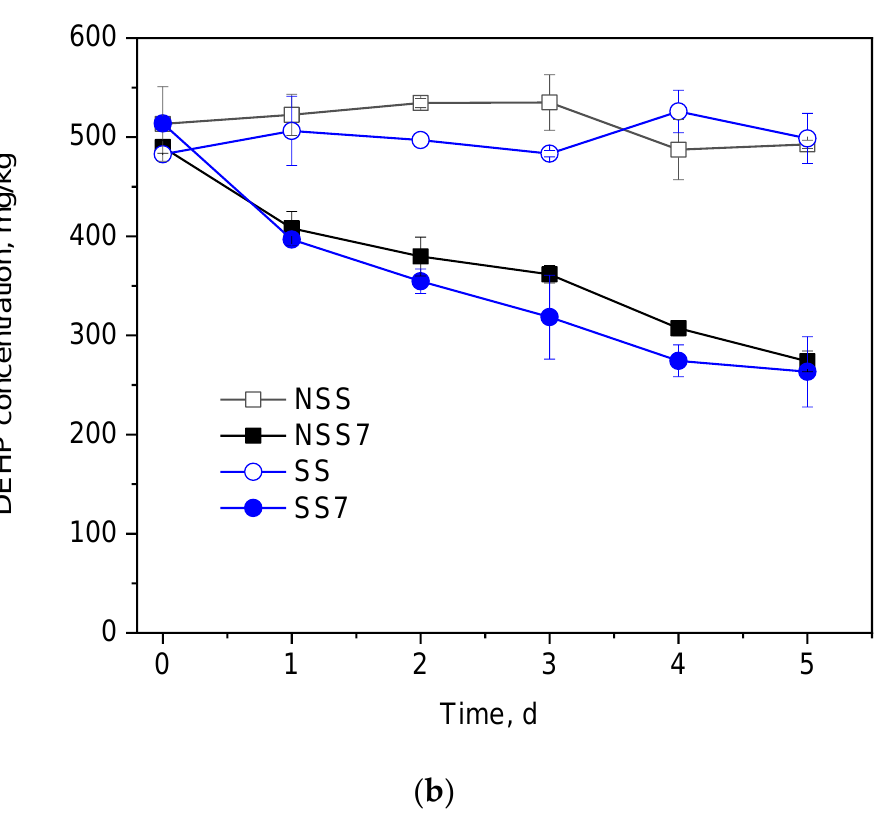
Figure 3. ( a ) PAEs Degradation and growth ability of GZ-YC7 in the BSM containing 800 mg/L mixed four PAEs (200 mg/L of DEP, DBP, DEHP, and DnOP); ( b ) DEHP degradation by GZ-YC7 in soil. NSS: Non-sterilized soil without GZ-YC7; NSS7: Non-sterilized soil with GZ-YC7; SS: Sterilized soil without GZ-YC7; SS7: Sterilized soil with